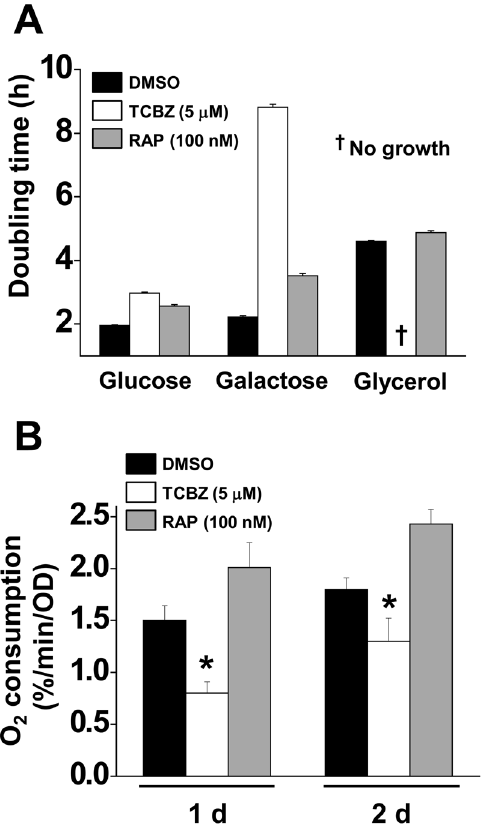
Figure 4. Effects of triclabendazole and rapamycin on carbon source utilization and O 2 consumption. (A) Carbon source utilization. Cells were inoculated in SC-glucose, -galactose, or -glycerol medium with the drug (triclabendazole, TCBZ; rapamycin, Rap) or DMSO and incubated with shaking at 30 u C. Absorbance ( A 600 nm ) was measured every 3 h, and doubling time was calculated as described in the methods. Values are the mean 6 SD of the three independent experiments. (B) O 2 consumption. Cells were inoculated in SC-glucose medium with the drug or DMSO and incubated for indicated times at 30 u C with shaking. Before determining the rate of O 2 consumption, the absorbance of each sample was measured. Samples were then transferred to an airtight chamber maintained at 30 u C, and the oxygen content was monitored for at least 5 min. Values are the mean 6 SD of the three independent experiments. *, p , 0.05 (versus